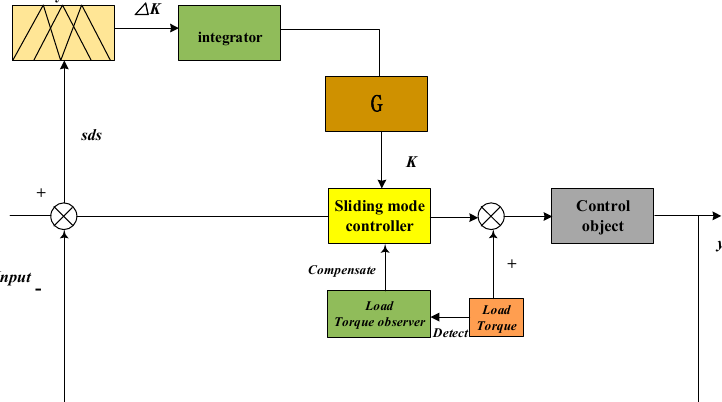
Figure 4. Control block diagram of the fast terminal sliding mode control (FTSMC) system based on fuzzy rules.